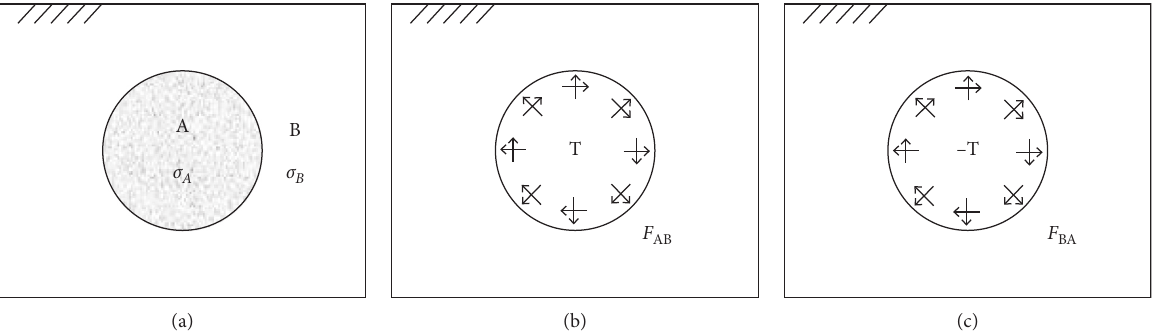
Figure 5: State of the surrounding rock before and after excavation. (a) Before excavation. (b) Load on B posed by A after excavation. (c) Load on A posed by B after